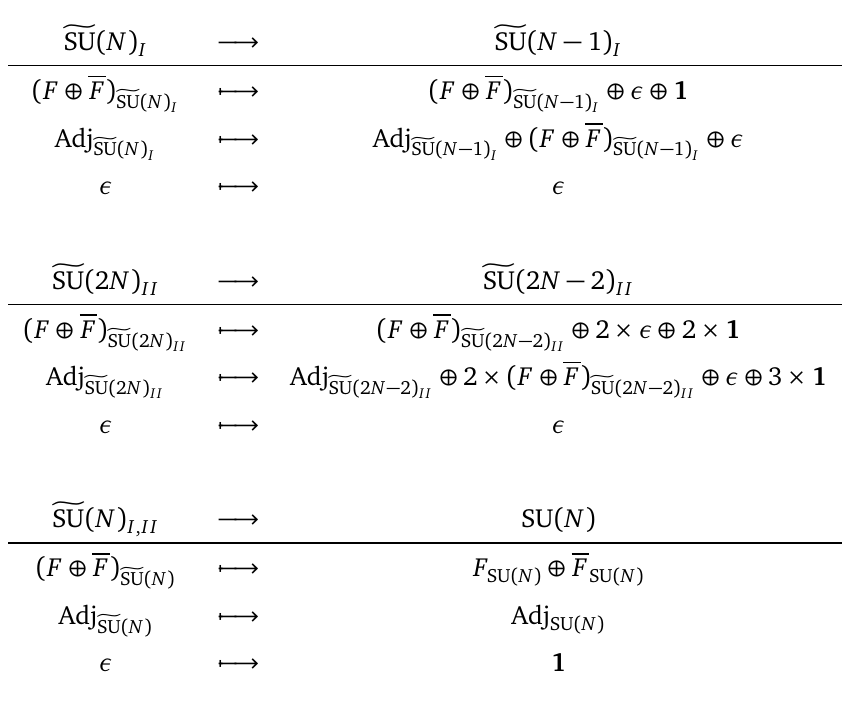
Table 3: Summary of branching rules for (cid:221) SU ( N )